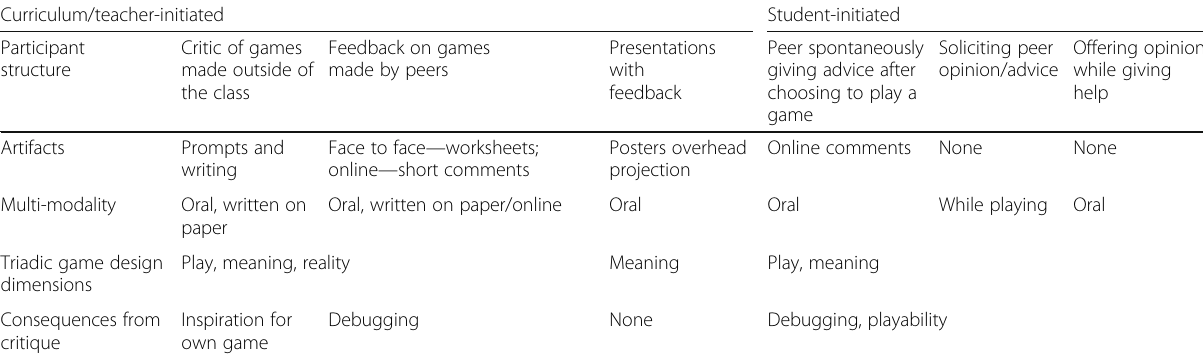
Table 1 A summary of the forms of critique that were enacted in the classroom that were teacher-initiated (columns 2 – 4) or student-initiated (columns 5 –